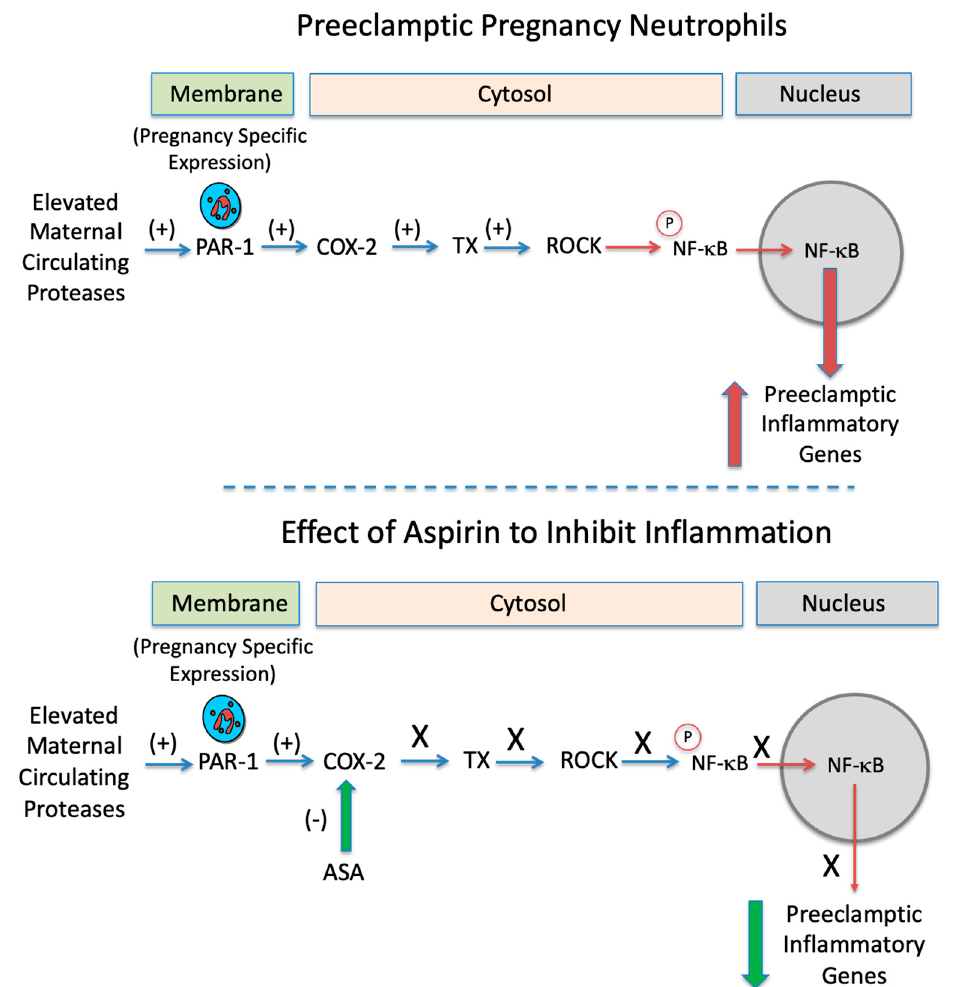
Figure 8. Mechanism for aspirin to inhibit neutrophil inflammatory response. Elevated levels of proteases in the maternal circulation of preeclamptic women activate the pregnancy specific expression of PAR-1 on neutrophils ( Top ). PAR-1 then activates COX-2 to increase thromboxane which activates RhoA kinase. RhoA kinase phosphorylates NF- κ B which causes its translocation from the cytosol to the nucleus to increase the expression of inflammatory genes. Aspirin (Bottom), by inhibiting COX-2, prevents activation of the downstream mediators of PAR-1, so phosphorylation of NF- κ B does not occur. NF- κ B remains in the cytosol and does not translocate into the nucleus to increase preeclamptic inflammatory genes. Inhibition of PAR-1 downstream signaling is a new mechanism for the anti-inflammatory effects of aspirin. (TX, thromboxane; ROCK, RhoA kinase; P, phosphorylation; ASA, aspirin).